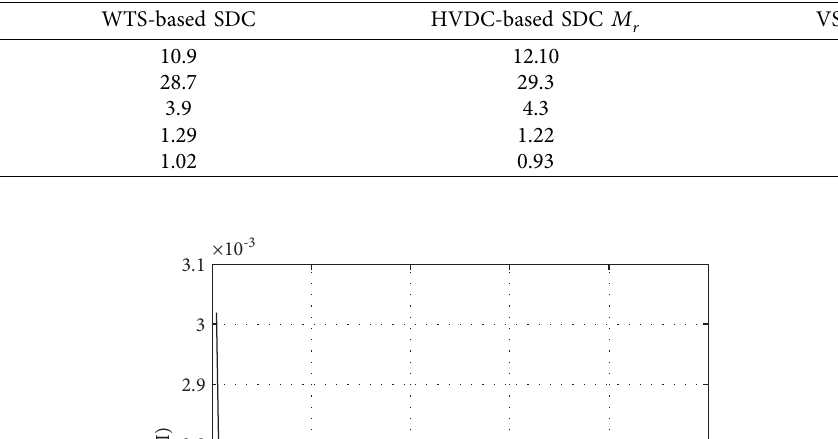
Table 1: The final coefficients’ values of SDCS.